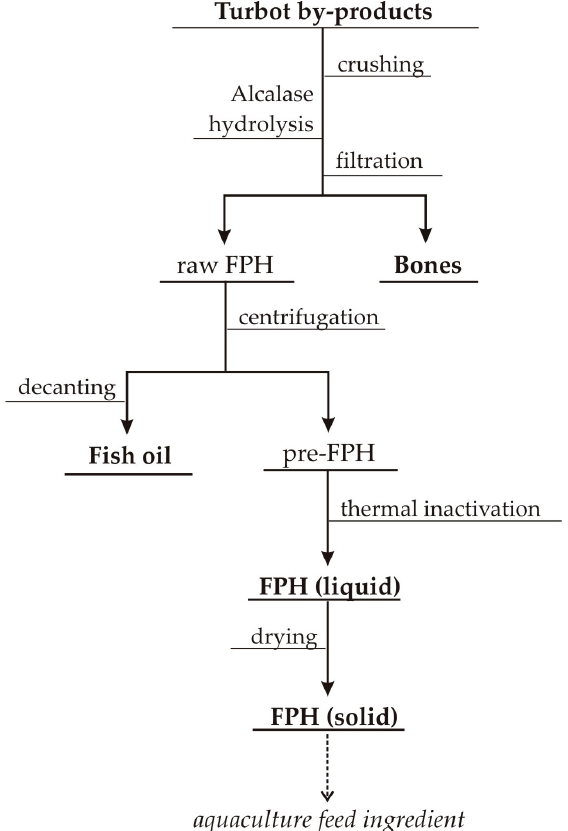
Figure 1. Schematic flowchart of turbot by-products processed through enzymatic hydrolysis.